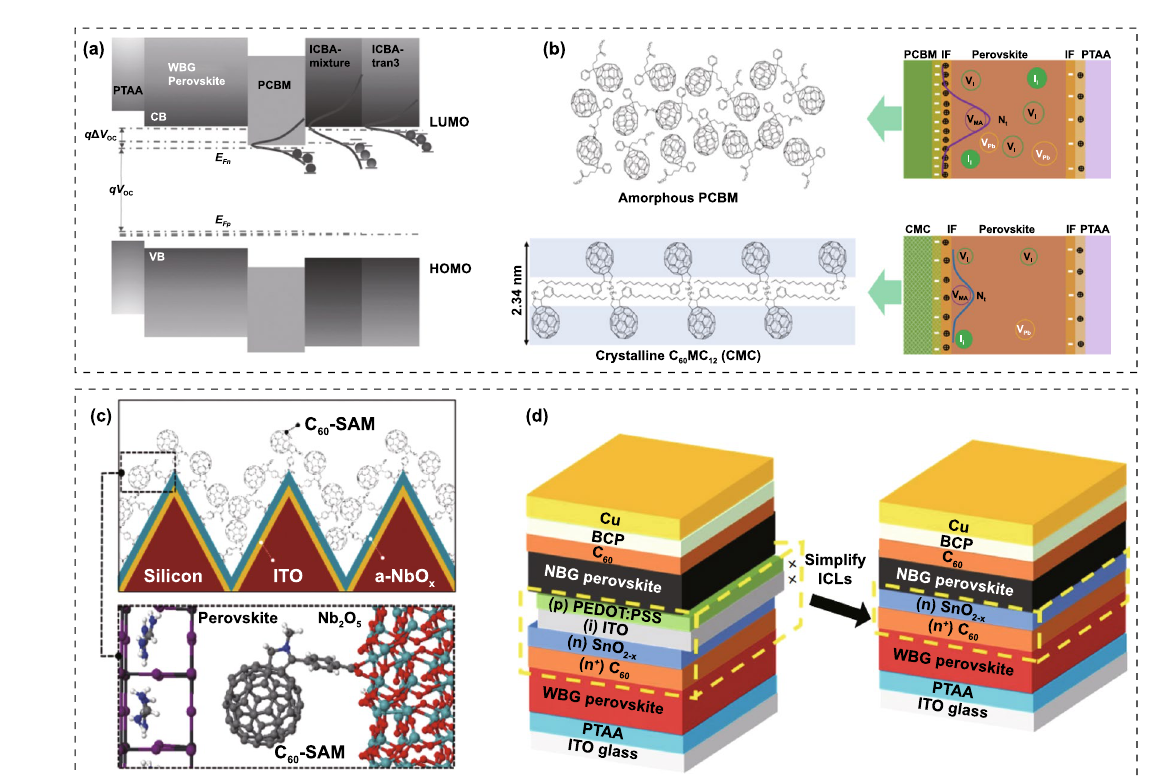
Fig. 12 a Schematic illustration of how energy level and energy disorder of ETLs influences the device V OC . Reproduced with permission from Ref. [196]. Copyright 2017, Wiley–VCH. b Schematic illustration of the mechanism for performance enhancement in device with crystalline fullerene derivatives. Reproduced with permission from Ref. [197]. Copyright 2018, American Chemical Society. c Schematics of C 60 -SAM self-assembly process on